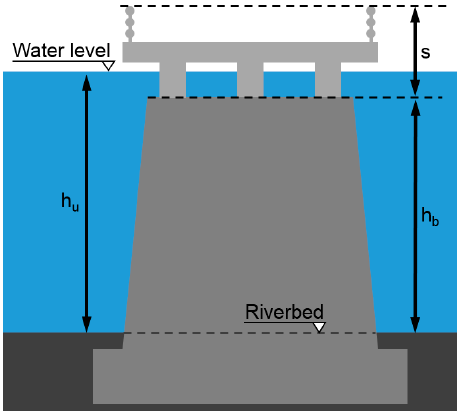
Figure 1. Graphical representation of the variables, h u , h b , and s, used in Equations (1) and (2).